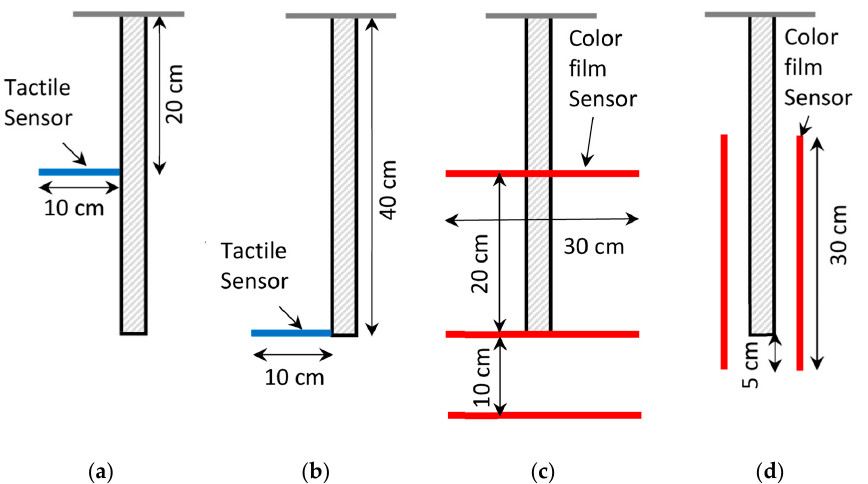
Figure 17. Schemes of the tests. ( a ) The tactile sensor placed horizontally at the half of the pile depth P1.R.0.5H.TS and P1.S.0.5H.TS. ( b ) The tactile sensor placed horizontally at the pile depth P3.S.H.TS and P4.R.H.TS. ( c ) The color film pressure sensors placed horizontally P5.R.CFS. ( d ) The color film pressure sensor placed vertically at different depths P6.R.CFS.